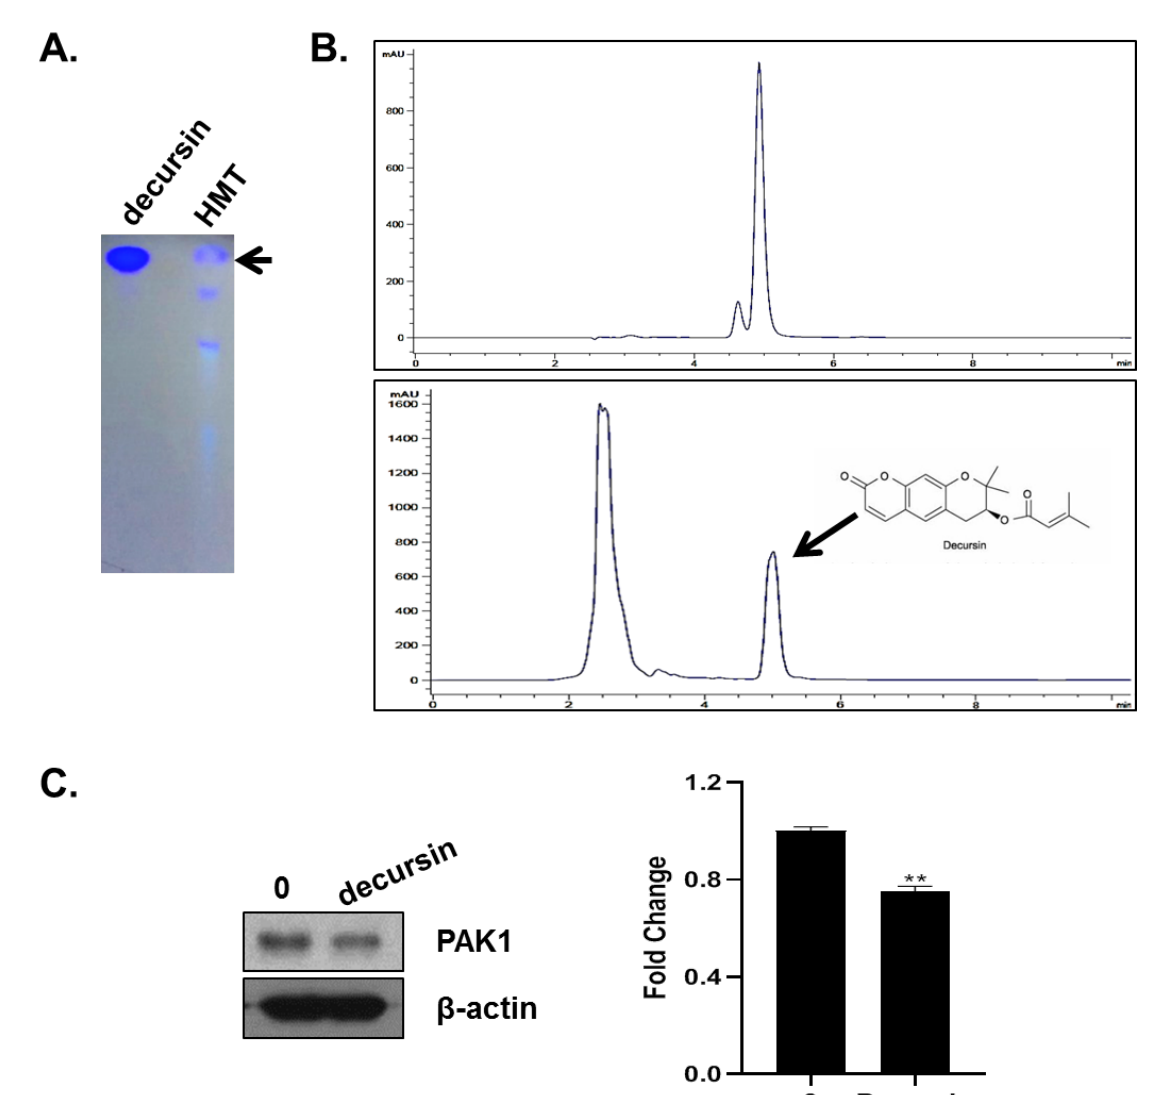
Figure 6. HMT contains decursin that inhibits PAK-1. ( A ) TLC analyses of HMT. For the detection of decursin, the TLC plate was dipped in 10% sulfuric acid to char carbon-containing compounds. ( B ) HPLC profile. Upper section: standard of decursin, lower section: HMT. ( C ) Changes in PAK-1 expression in response to decursin in PC-3 cells. Cells were treated with decursin (at 10 μM) for 24 h. Cell lysates were prepared and subjected to Western blotting using PAK-1 antibodies. The bar graph indicates the ratio of the protein of interest to β-actin by densitometric analysis presented as fold changes of the control. Data represent mean ± SD. ** p < 0.01 compared with control.